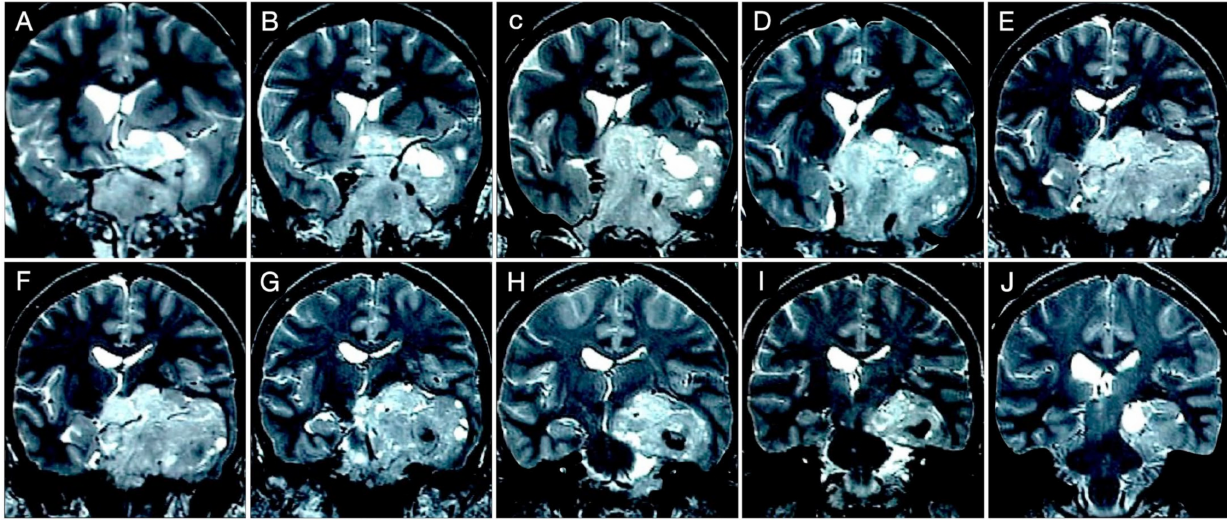
Figure 15. Preoperative coronal ( A – J ) T2-weighted contrast-enhanced MRI. Scale bar: 5 cm. Not surprisingly, by considering the laterality of the lesion, the patient had lateral homonym hemianopsia (Figure